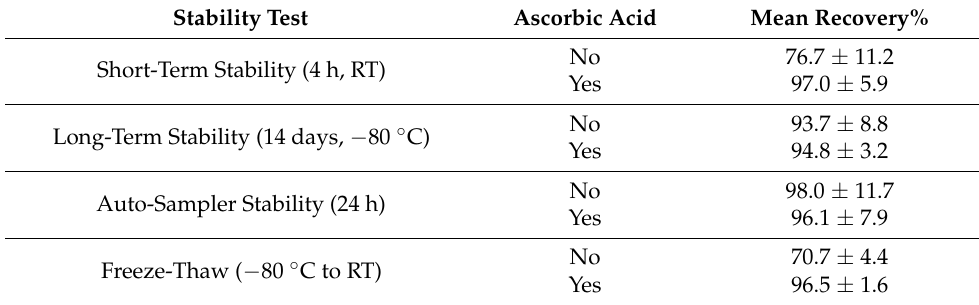
Table 1. Mean recovery of OJT007 in the presence or absence of ascorbic acid in rat